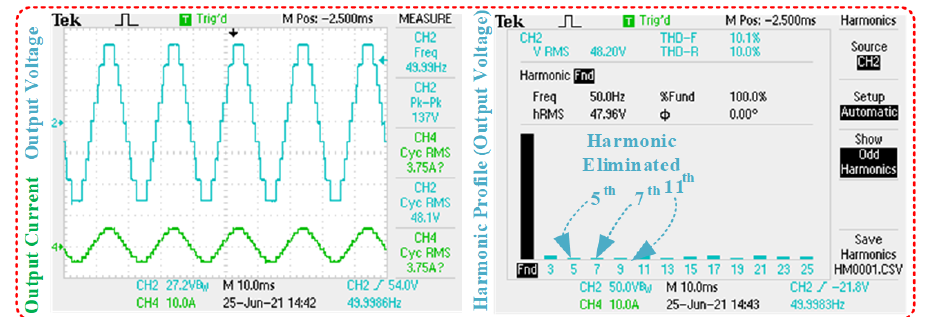
Figure 26. Outputs and harmonic profile of nine-levels MLI.